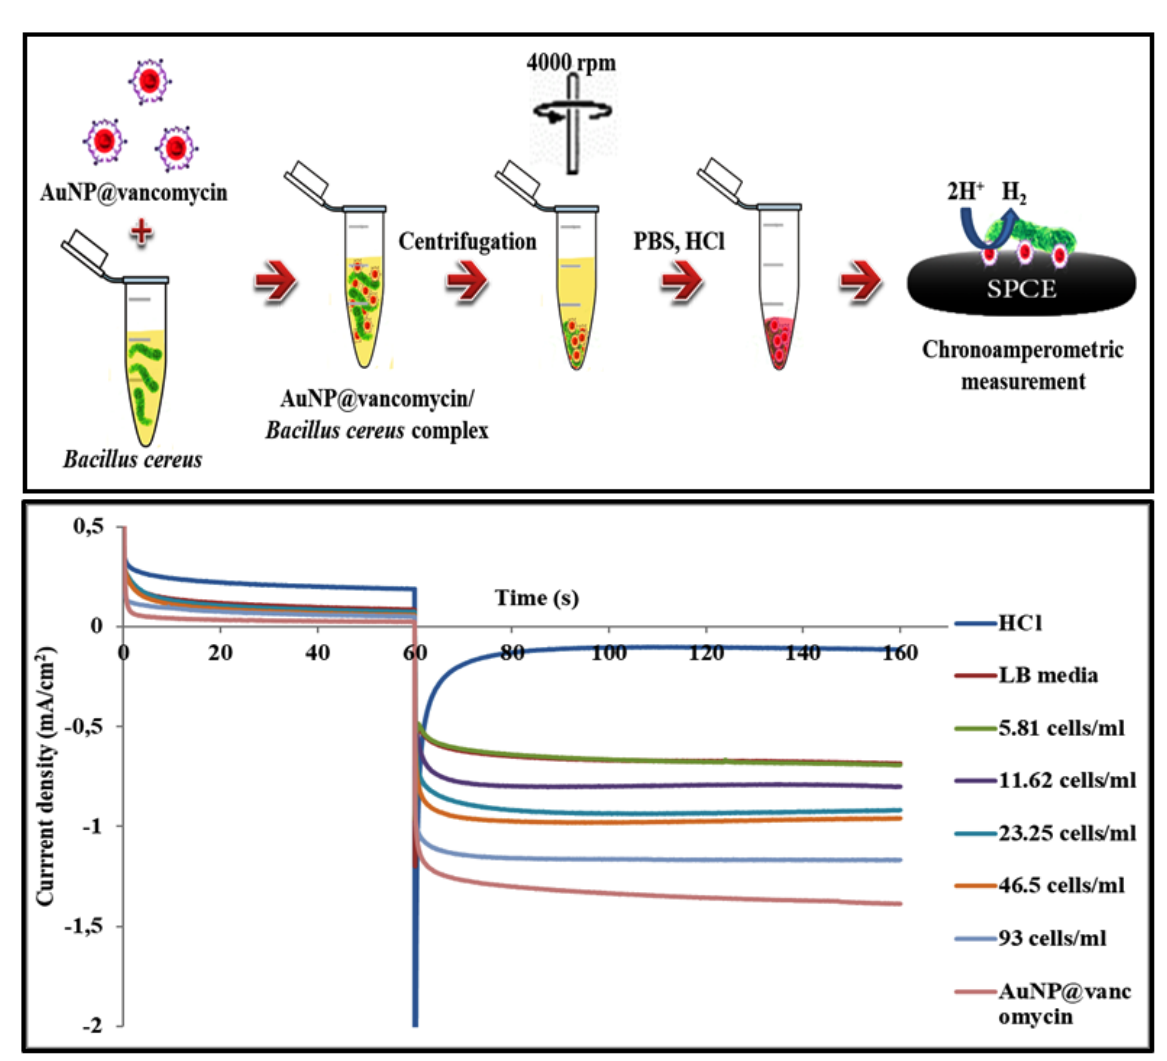
Figure 4. Schematic illustration of the strategy used to develop the vancomycin-coated gold nanoparticle-based centri- chronoamperometric assay for the rapid and sensitive detection of foodborne bacteria (upper panel). Chronoamperometric curves obtained without bacteria (LB media) and with 5.81; 11.62; 23.25; 46.5 and 93 cells/mL of the bacterial strain, B. cereus (lower panel).